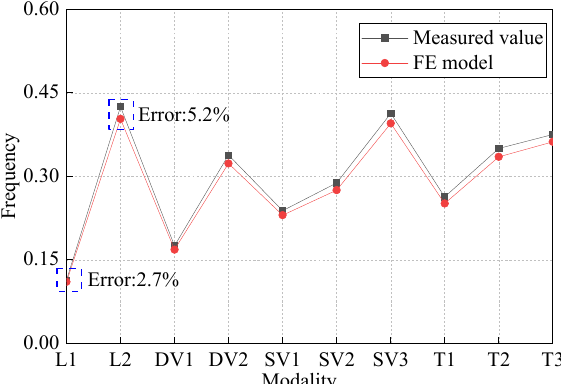
Figure 5. Comparison of structure frequency (L is lateral mode; DV is dissymmetry vertical mode; SV is symmetrical vertical mode; T is torsional mode).